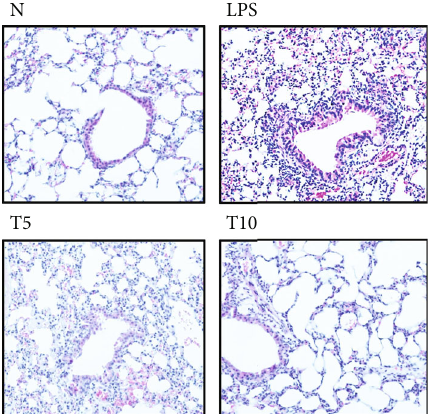
Figure 2: Tomatidine reduces neutrophil in fi ltration in lung tissue. HE staining ( × 200 magni fi cation) of lung tissue to observe neutrophil in fi ltration. N group: normal control mice; LPS group: LPS treatment only; T5 group: 5mg/kg tomatidine plus LPS; T10 group: 10mg/kg tomatidine plus